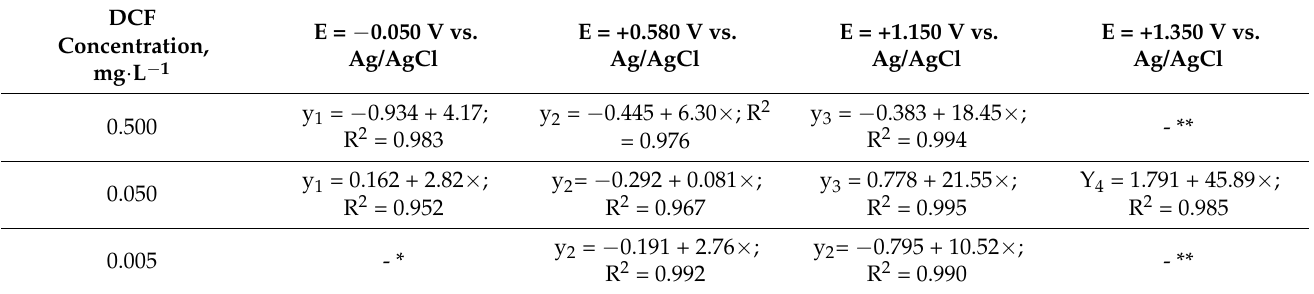
Table 4. Equations of the anodic peaks currents vs. the square root of the scan rates for different